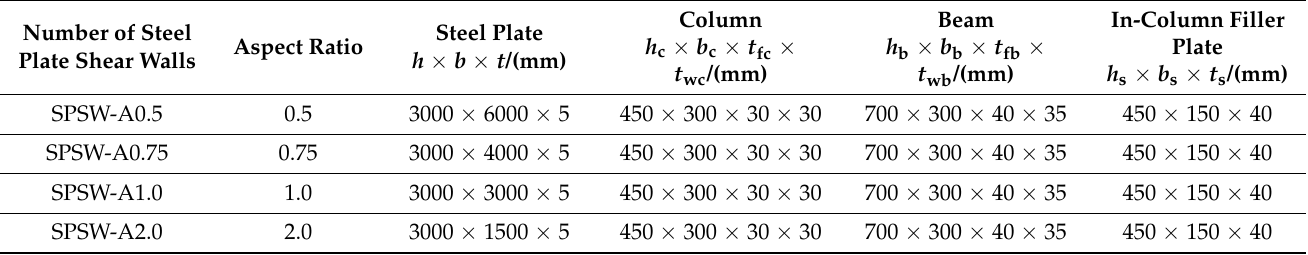
Table 3. SPSW optimization scheme size